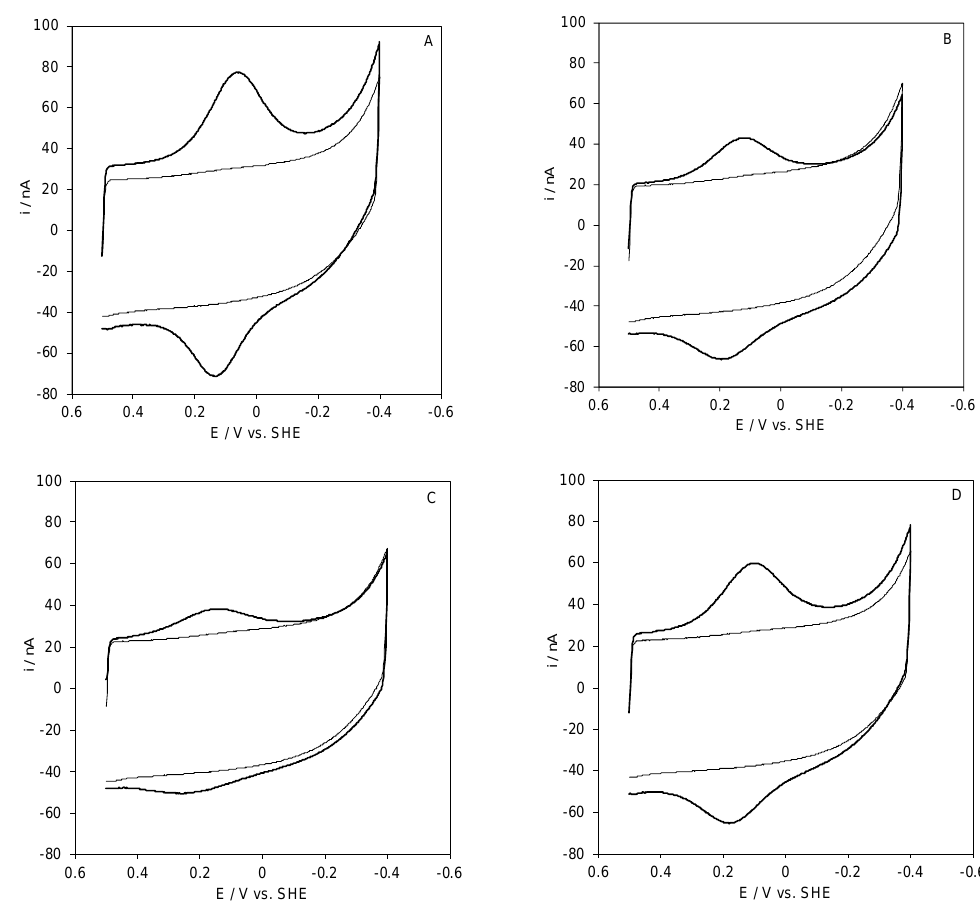
Figure 1. Cyclic voltammograms for wt Streptomyces coelicolor small laccase (SLAC) electrostatically bound on a polycrystalline gold electrode coated with a SAM of MUA ( A ), 1:1 MUA/MU ( B ), 1:2 MUA/MU ( C ), and 1:3 MUA/MU ( D ). CVs were recorded in 5 mM Tris-HCl buffer, 5 mM sodium perchlorate, pH 7. Scan rate: 0.05 V s −1 , T = 20 °C.